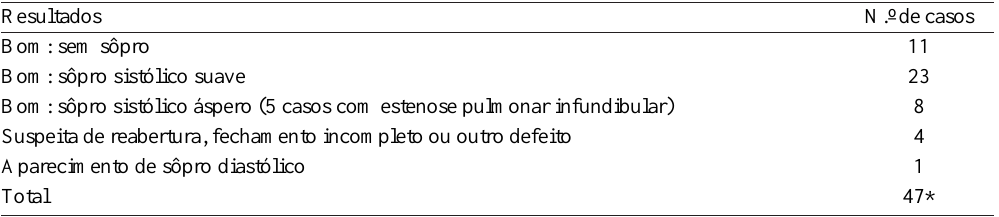
Tabela 2. Resultados pós-operatórios imediatos (46 pacientes)